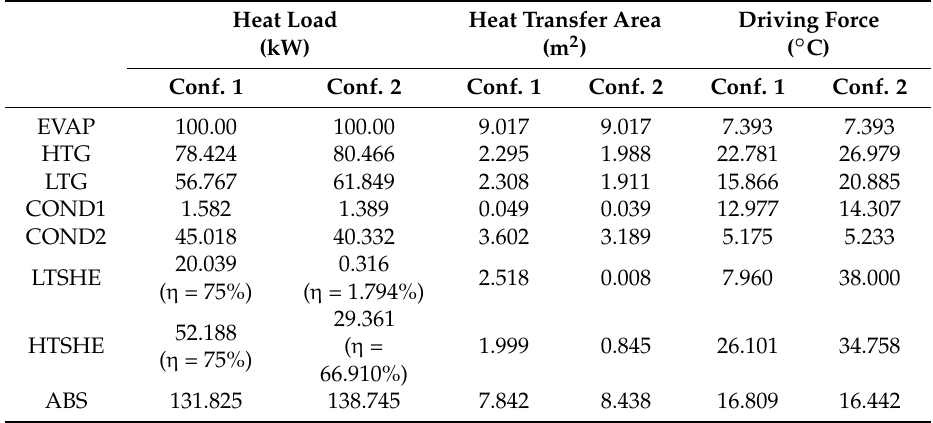
Table 5. Optimal values of heat transfer areas, heat loads, and driving forces obtained for configurations Conf. 1 and Conf. 2 for a cooling capacity of 100 kW.